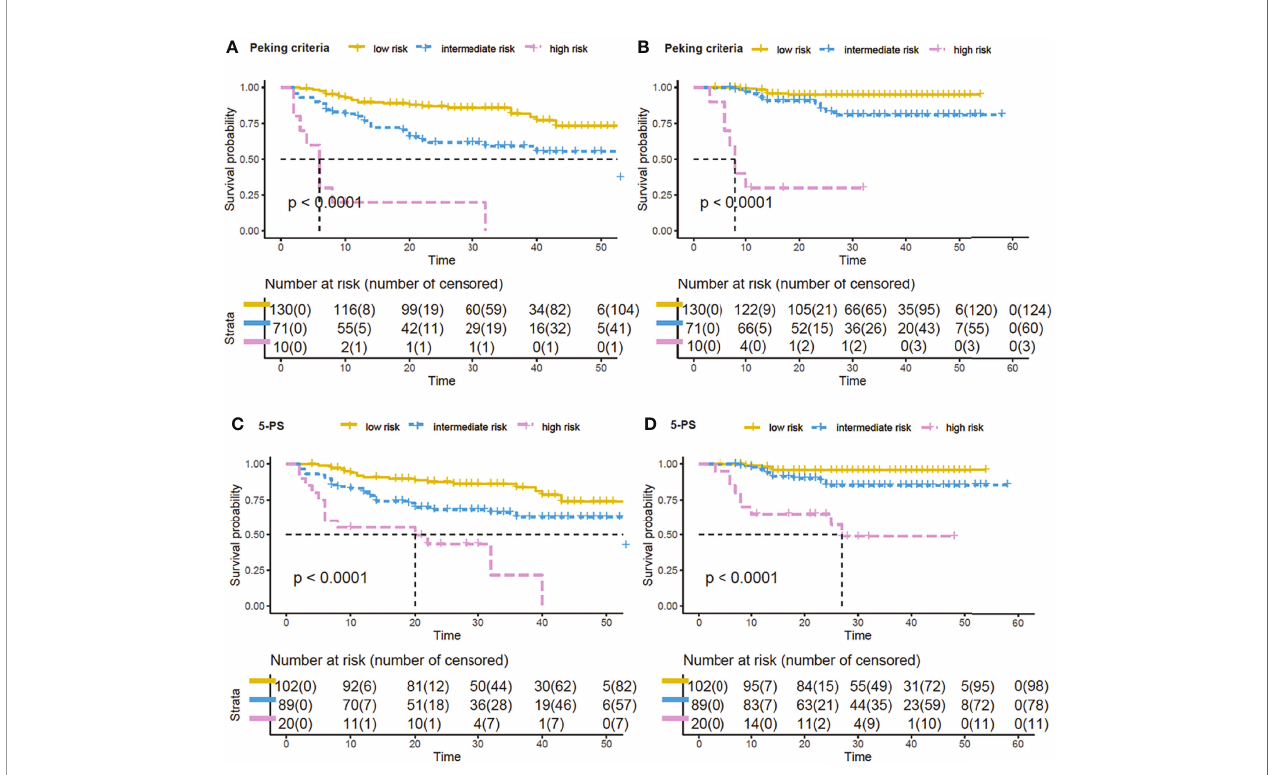
FIGURE 2 | Survival curves by new model of three PET parameters by using Peking criteria or Deauville 5-point scales (5-PS). Kaplan – Meier analysis of progression- free survival (PFS) and overall survival (OS) by the new prognostic model by combining baseline metabolic tumor volume (MTV), PET after two cycles of therapy (PET-2) and PET after four cycles of therapy (PET-4): low-risk, no risk factor; intermediate-risk, 1 or 2 risk factors; high-risk, 3 risk factors. With Peking criteria, the respective 2-year PFS and OS of the 3 groups were 85.3% (95% CI, 79.2% – 91.4%) and 94.6% (95% CI, 90.3% – 98.8%) for low-risk patients (yellow curve); 58.6% (95% CI, 46.1% – 71.0%)